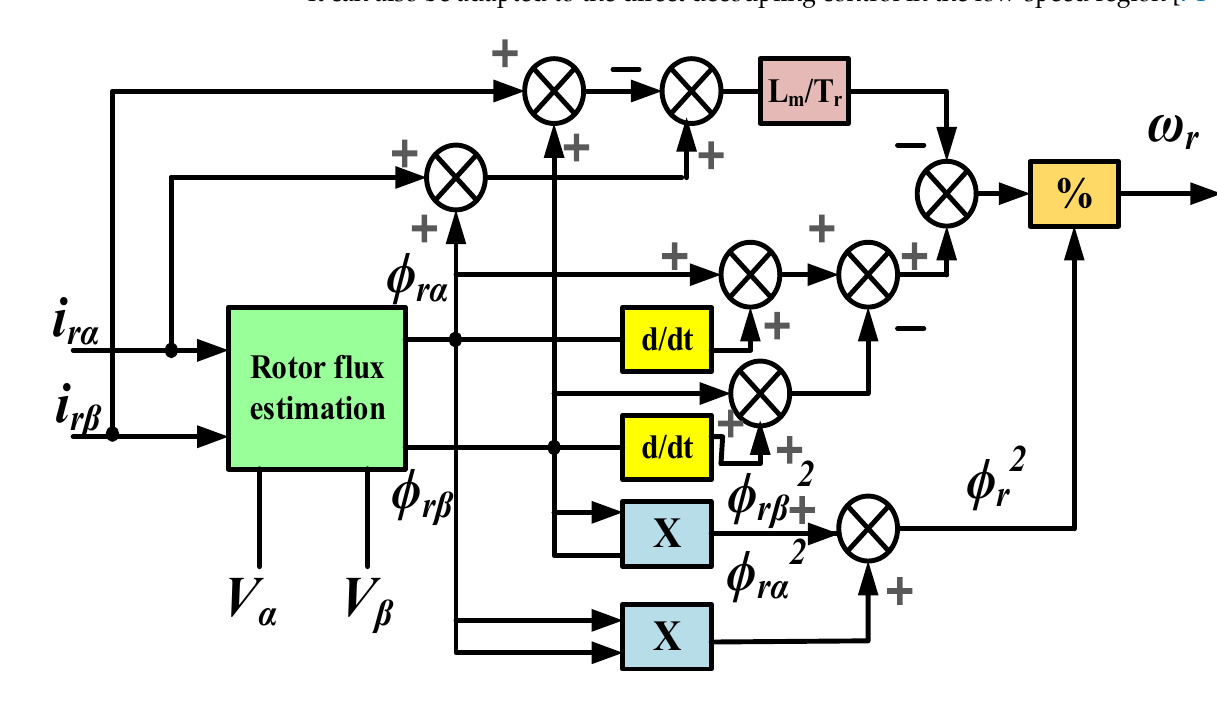
Figure 13. Speed estimation methods.